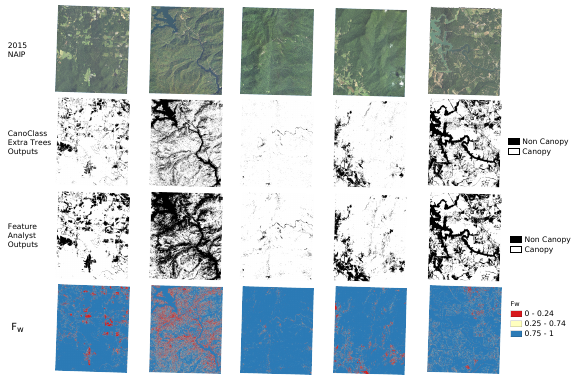
Table 3. F w values of the 20 random QQs chosen within the Blue Ridge Mountains district.